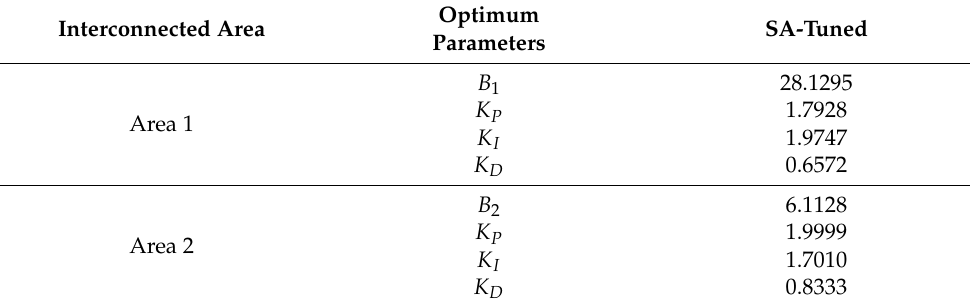
Table 4. System-tuned variables.